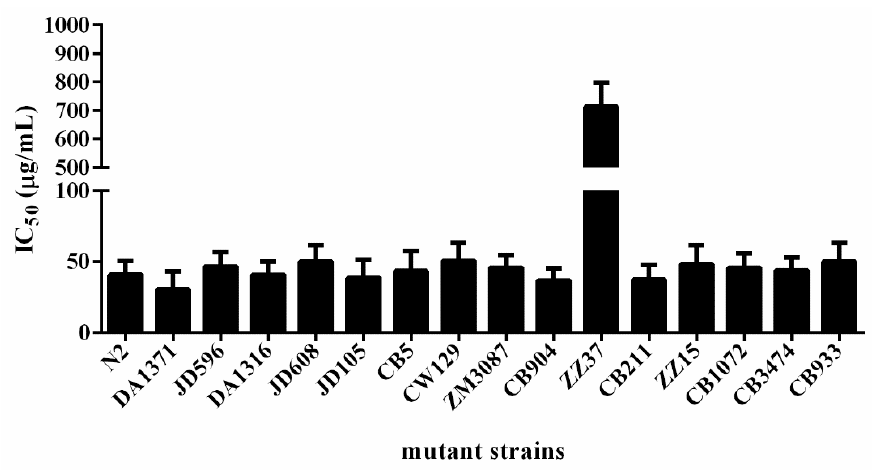
Figure 4. The anthelmintic activity (IC 50 ) of pharbitin on drug-resistant mutant C. elegans strains (mean ± S.D., n = 3). For a list of strains, see Table 2.